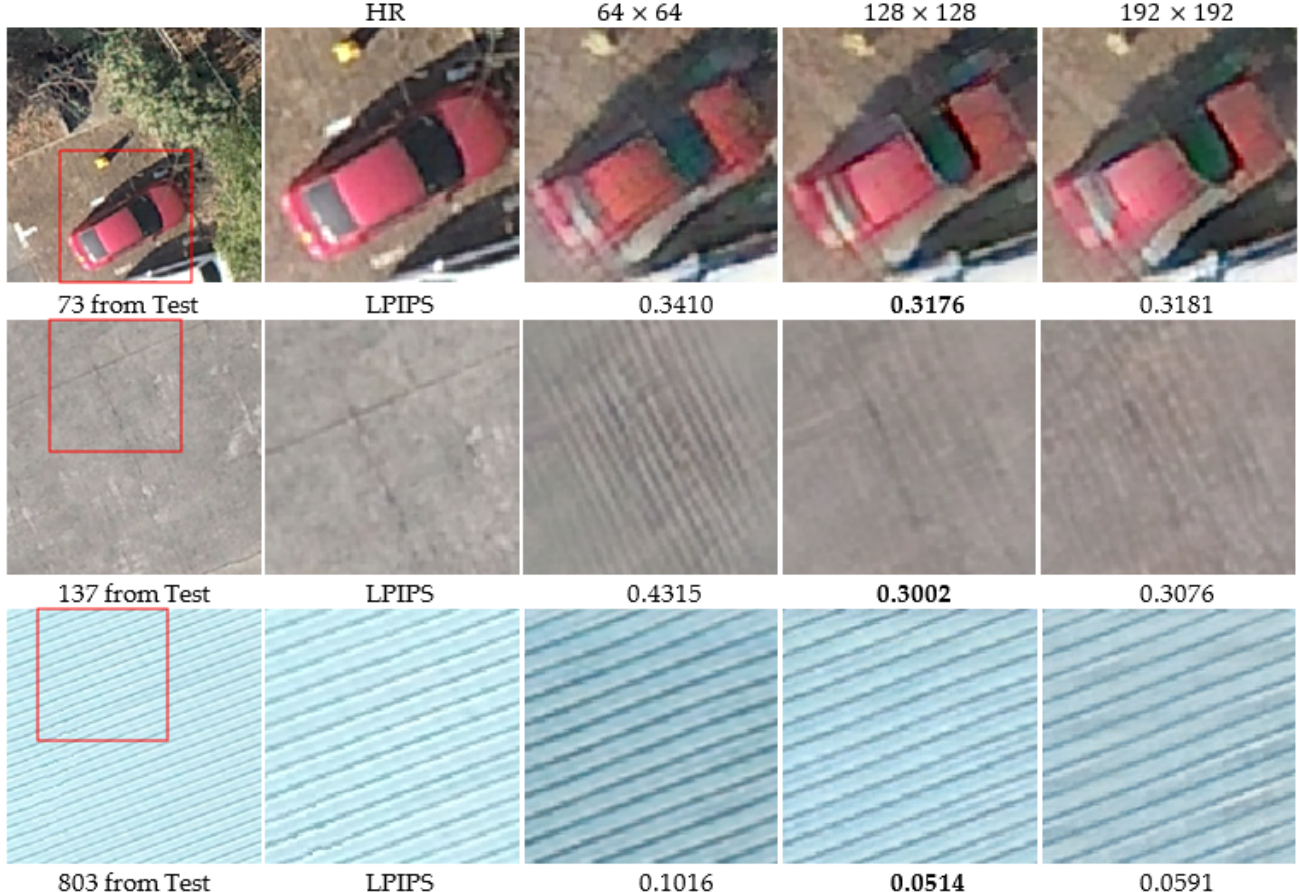
Figure A4. Reconstruction results with different random crop sizes. The best performance in bold.